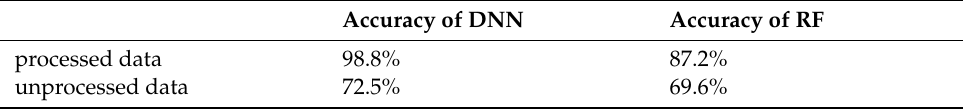
Table 2. Accuracy before and after data